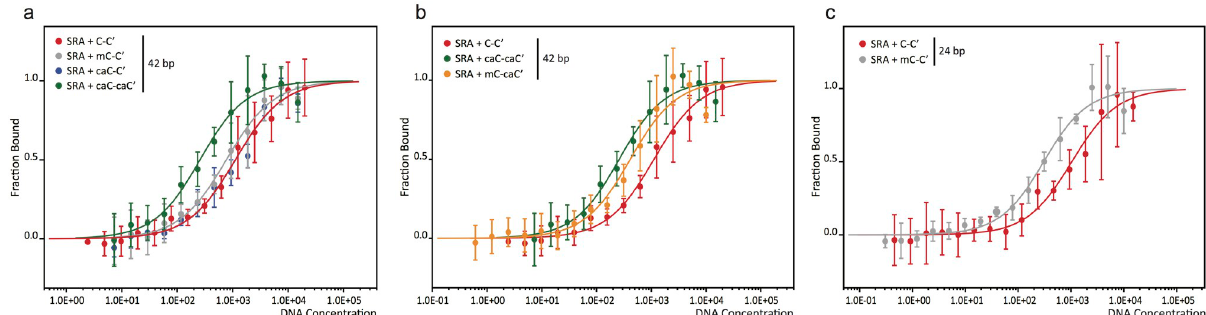
Fig 3. Microscale Thermophoresis experiments of UHRF1-SRA bound to DNA with modified CpG sites. (a,b) Dissociation constants of UHRF1 bound to a 42 bp DNA oligonucleotide: 1.10 ± 0.15 μ M for C-C’, 0.75 ± 0.11 μ M for mC-C’, 1.10 ± 0.29 μ M for caC-C’, 0.23 ± 0.05 μ M for caC-caC’, and 0.39 ± 0.11 μ M for mC-caC’. (c) Dissociation constants of UHRF1 bound to a 24 bp oligonucleotide; 1.01 ± 0.20 μ M for C-C’ and 0.28 ± 0.06 μ M for mC-C’. Curves show the fitted average values of 4–5 independent